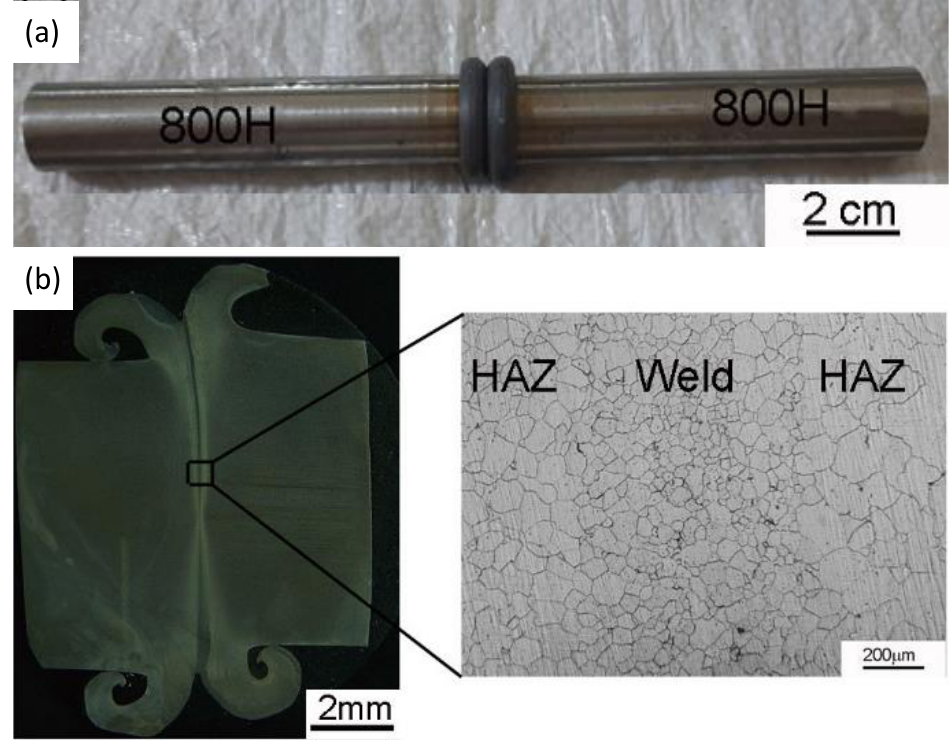
Figure 3. ( a ) The visual view of an Alloy 800H friction weld joint; ( b ) Macrograph of the friction weld joint with an inset showing the grain structure of the